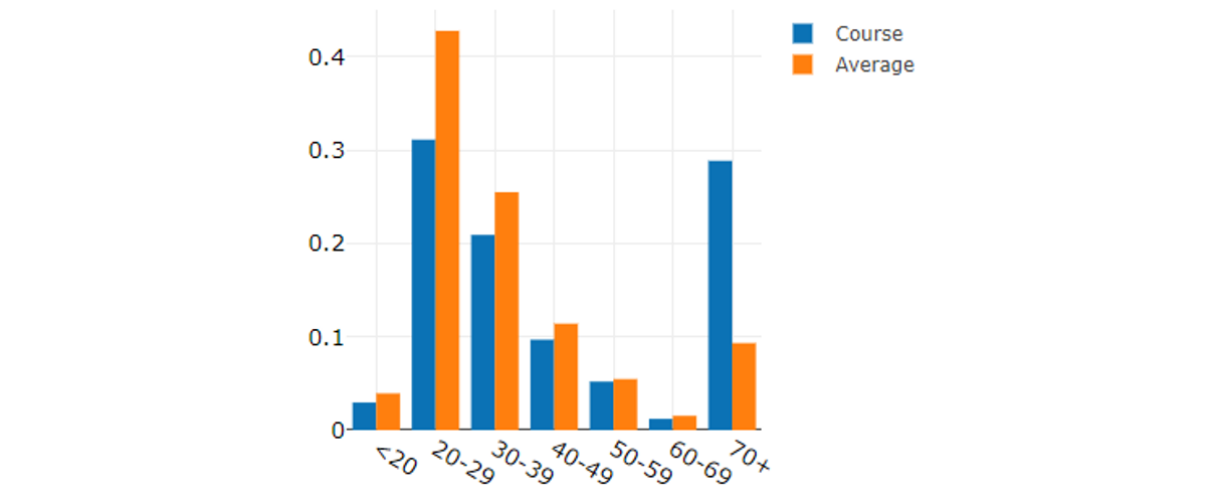
Figure 7. Spanish course use by age